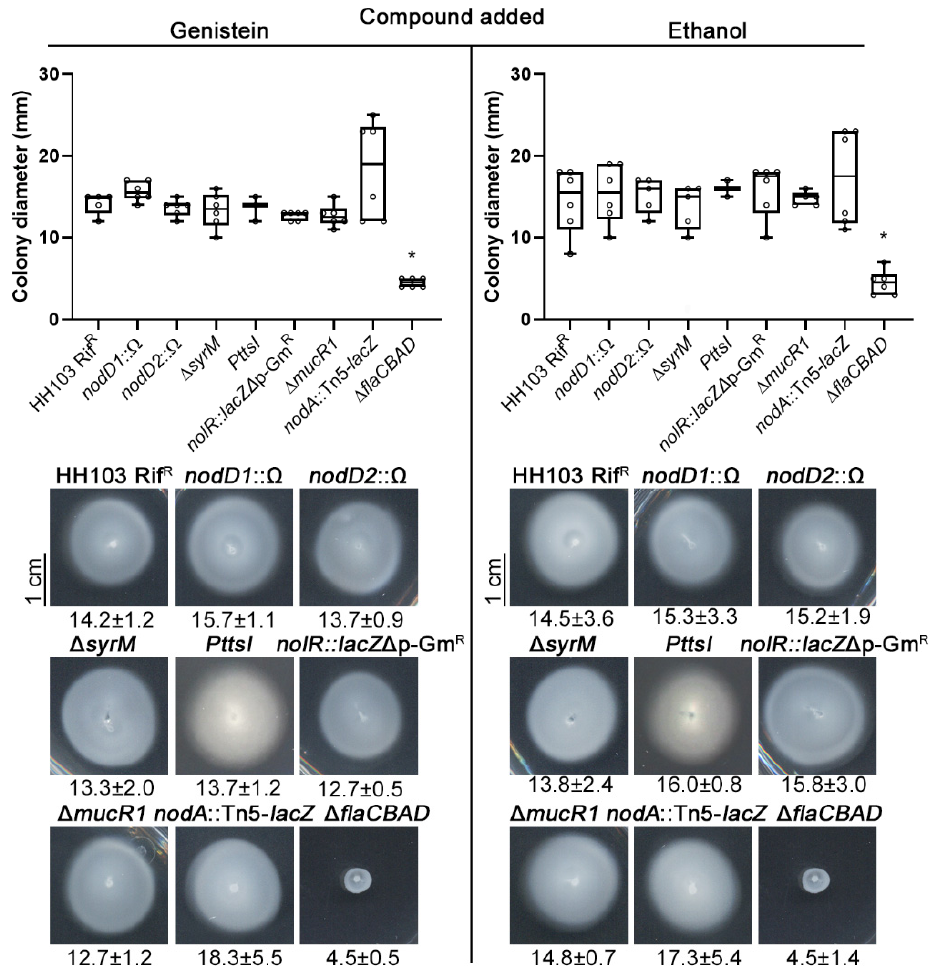
Figure 3. Swimming abilities of S. fredii HH103 and different mutants in the absence and the presence of genistein at 72 h. All data points are shown in box and whisker plots from at least three biological replicates performed with three technical replicates. Asterisks (*) indicate significant differences with the corresponding control sample using the non-parametric test of Mann–Whitney, α = 1%. Representative pictures of the motilities exhibited in the presence of genistein by the different S. fredii HH103 mutants analysed are also shown. Values under images represent the average and standard deviation of migration (given in millimetres and determined as described in the text).